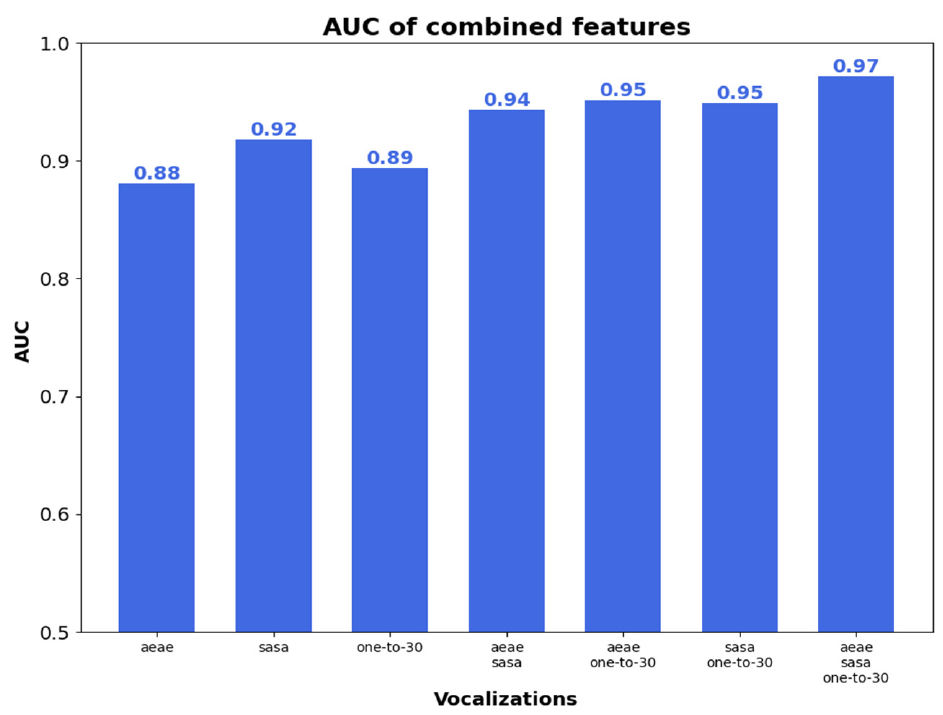
Figure 7. AUC with time ‐ dependent and ‐ independent features.